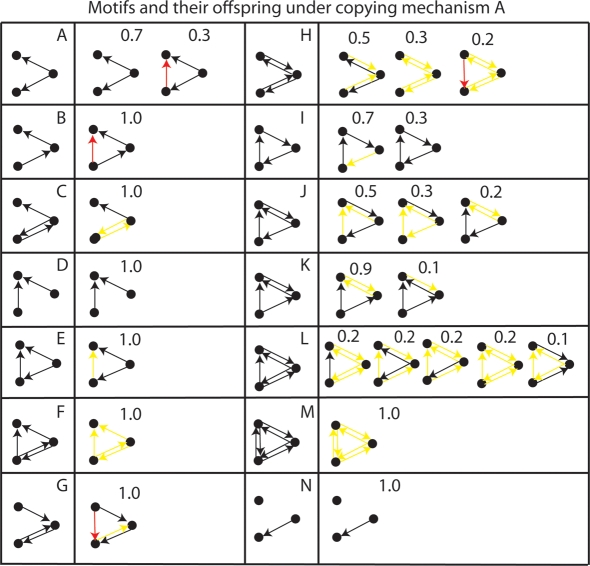
Motifs and the exploration distribution of offspring variants [29] resulting from copying by mechanism A.Red arrows show new connections, and yellow arrows show lost connections. The proportion of copies of each type is displayed above the copy structure. Neurons are referred to in the text as neuron 0 (top), neuron 1 (right), neuron 2 (bottom).